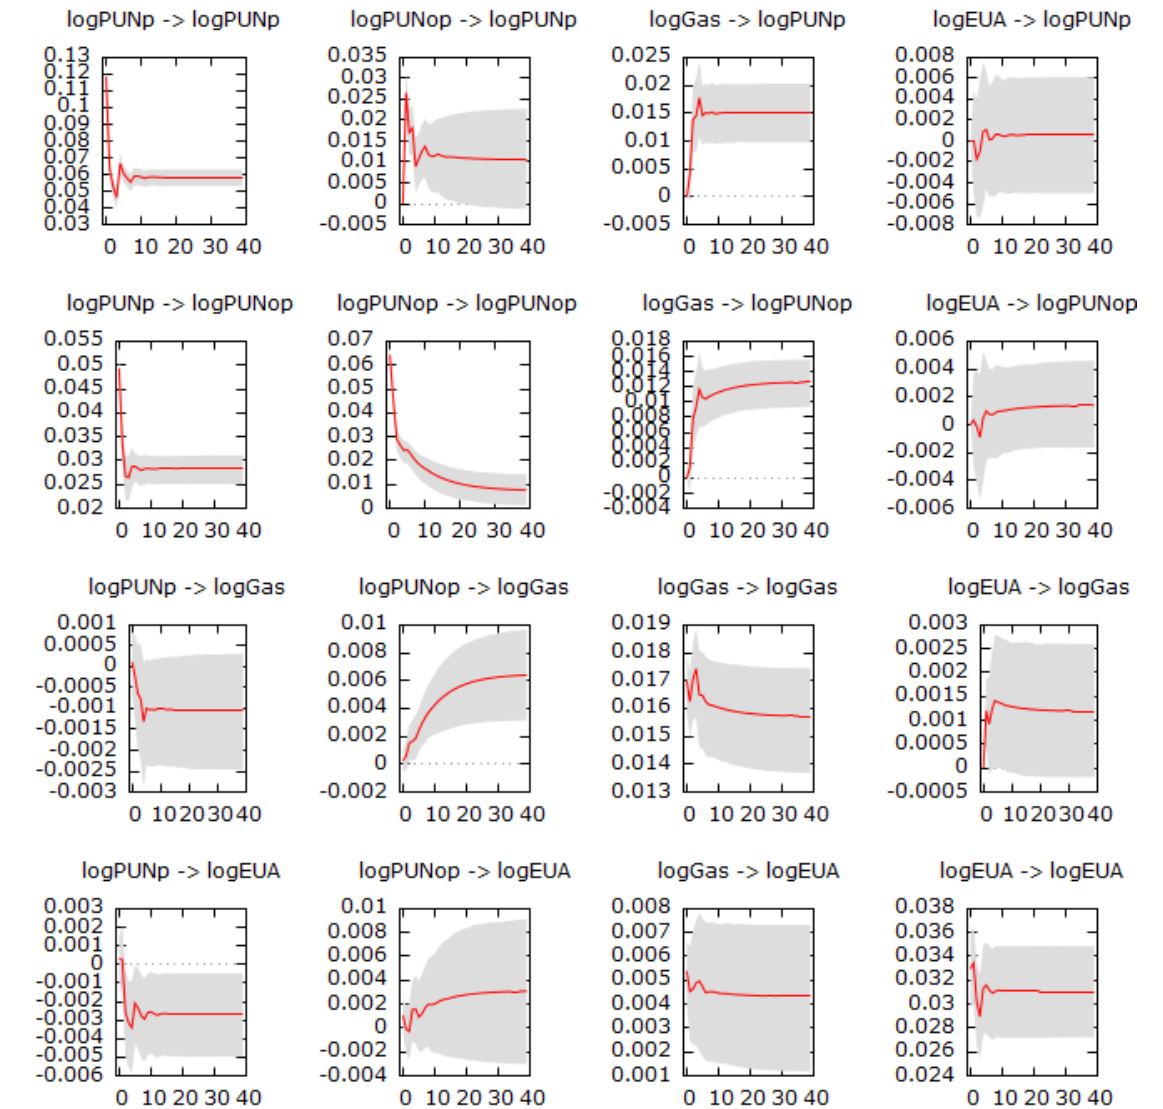
Figure 3. Impulse response functions of the VECM Model 4 (four variables, peak and off-peak PUN, two cointegration relations). The shaded area represents the 90% confidence interval.